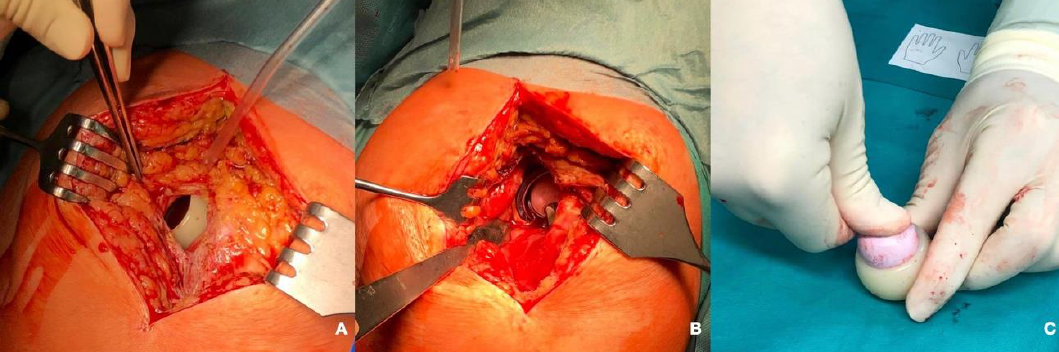
Figure 3. Intraoperative photographs show the dislocated liner ( A ) and the reduced head in the acetabular cup ( B ). An attempt to introduce manually the head in the liner to check for an abnormal weakness or defect was performed but was not possible ( C ).